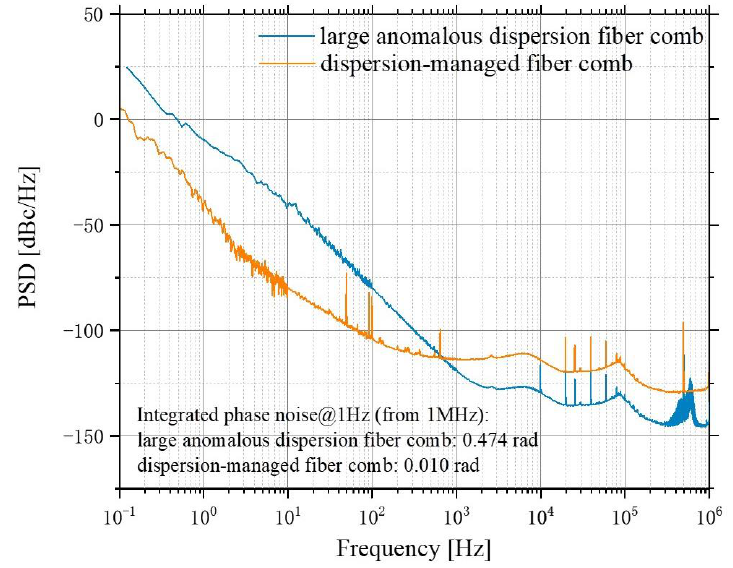
Figure 11. Phase noise measurement of the large anomalous dispersion fiber comb used in this work and another typical dispersion-managed fiber comb [32].